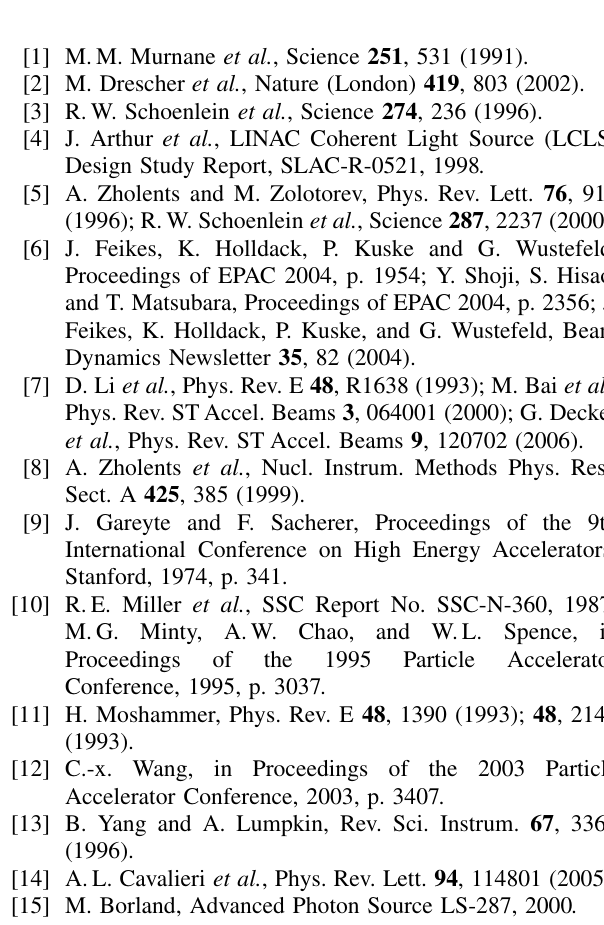
FIG. 9. (Color) The short-pulse generation